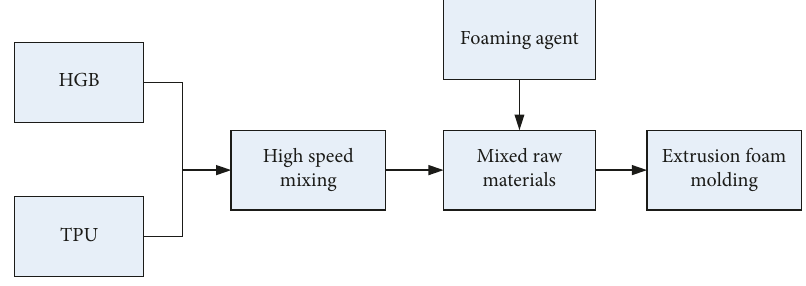
Figure 6: Extrusion foam preparation flow